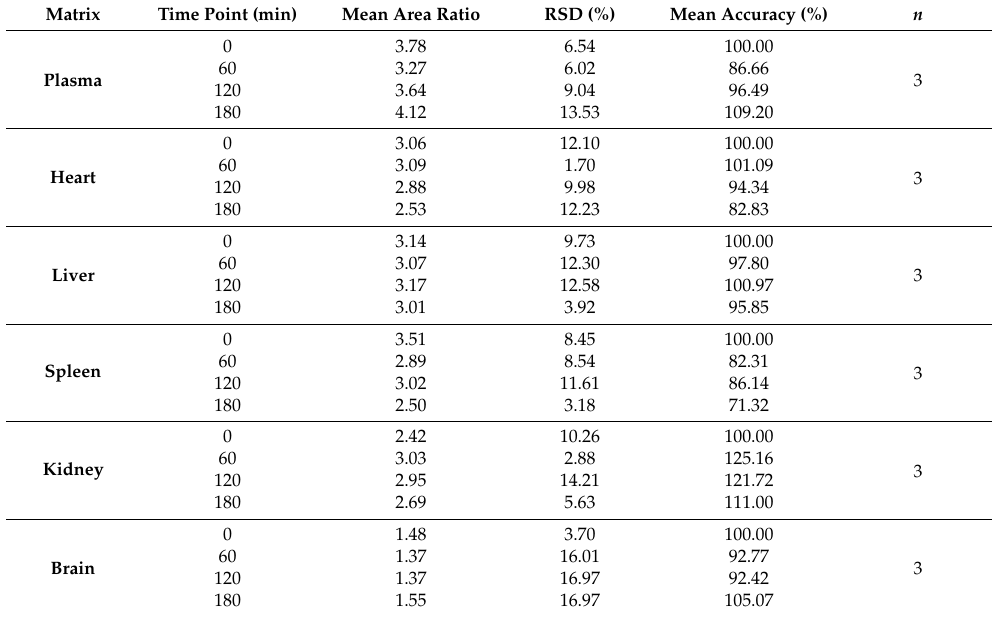
Table 3. Short-term stability results for